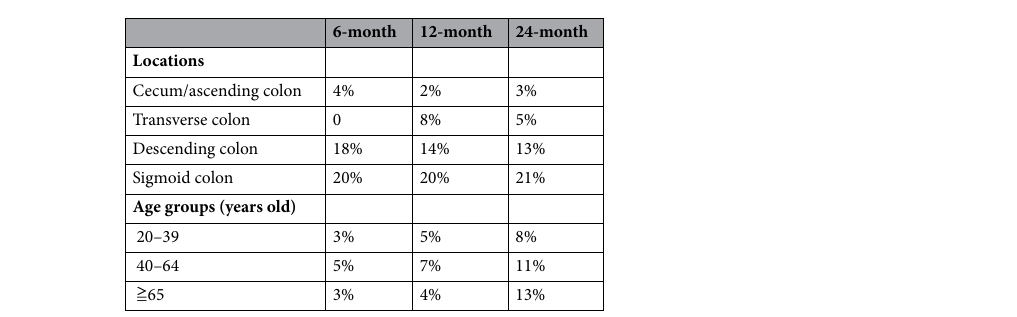
Table 3. The recurrence rates for patients with different locations and age